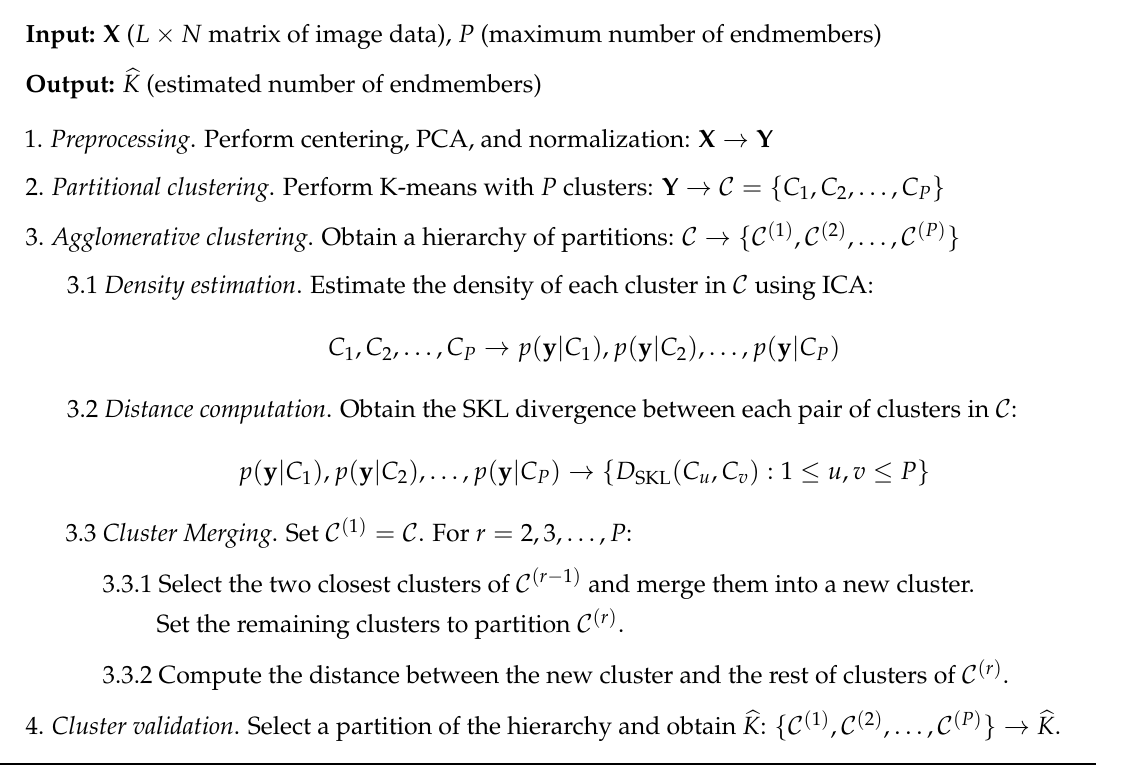
Algorithm 1: Estimation of the number of endmembers using agglomerative